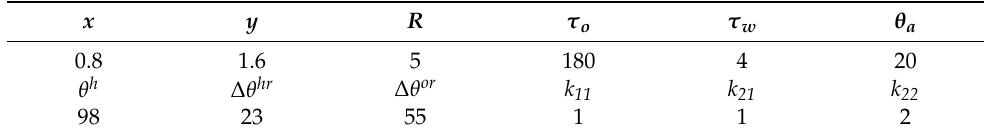
Table 2. Thermal characteristics of ONAN (Oil Natural Air Natural) distribution transformers at nominal conditions.